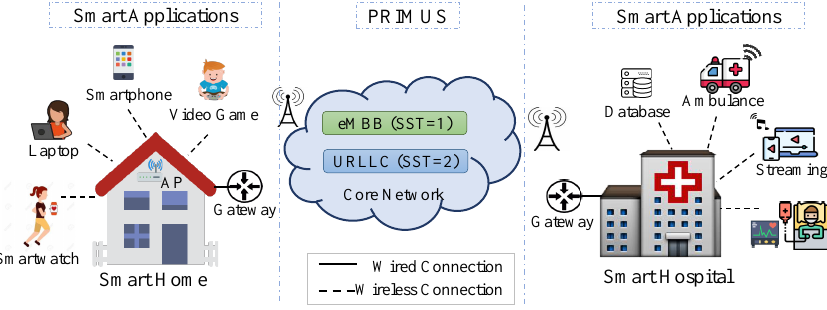
Figure 2. The PRIMUS network